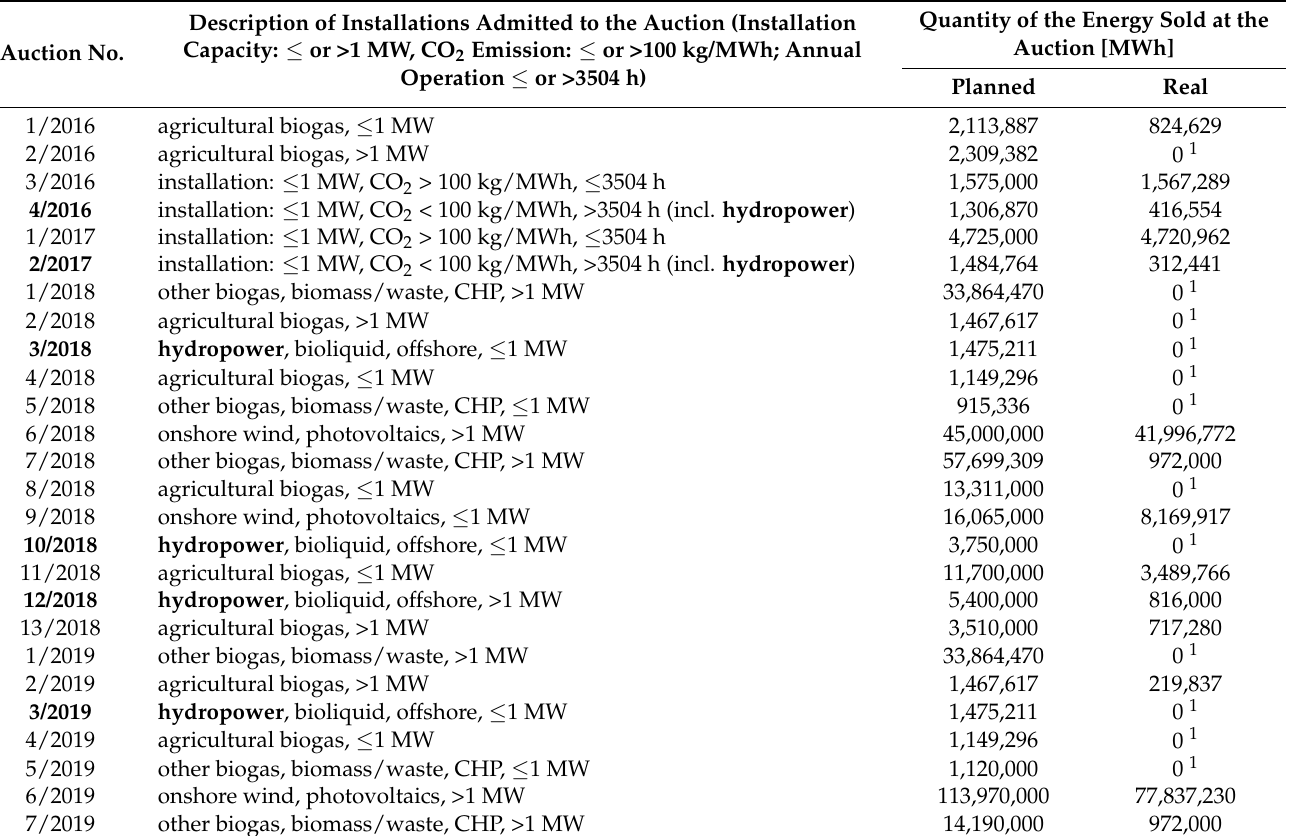
Table 8. Results of the RES electricity auction announced in